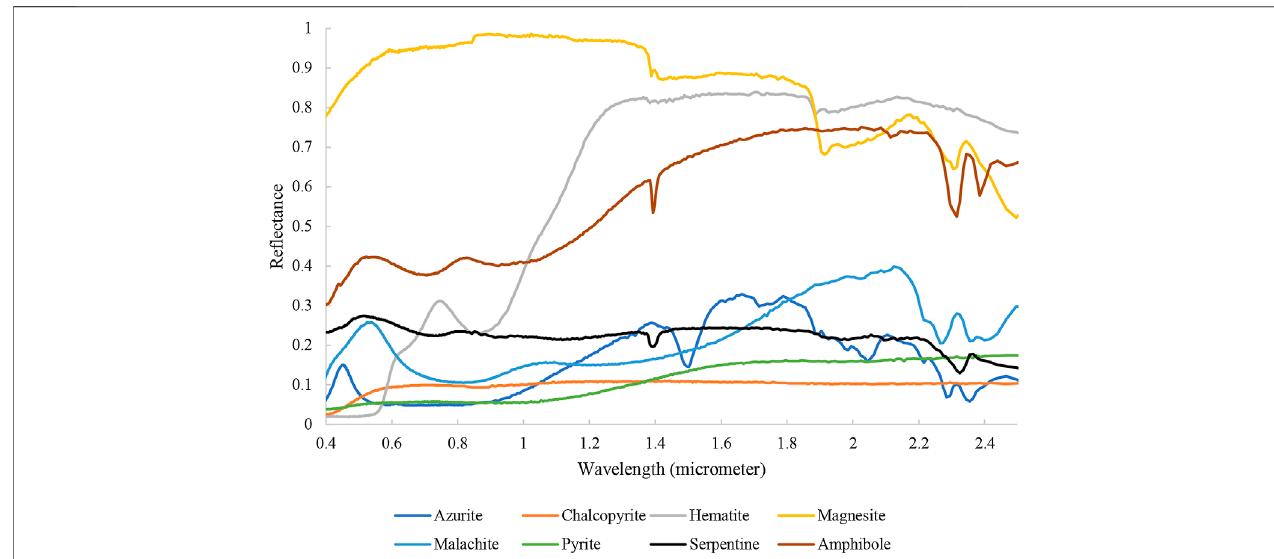
FIGURE 11 | United States Geological Survey spectral re fl ectance curves of selected iron, sulfur, copper minerals (Clark, 1999).